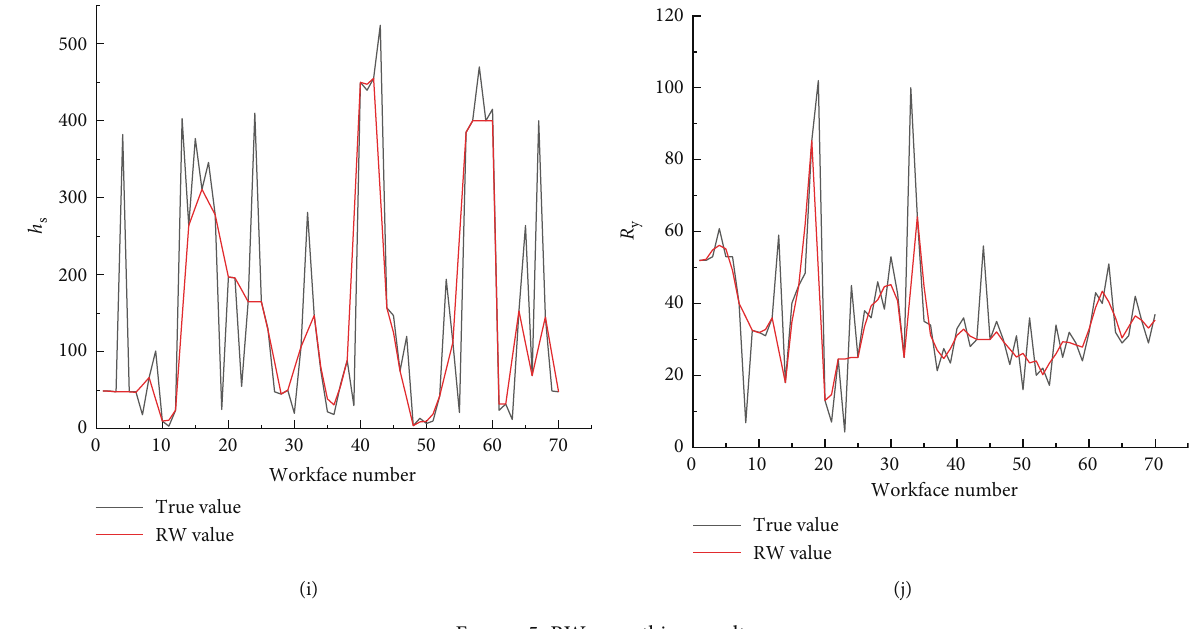
Figure 5: RW smoothing